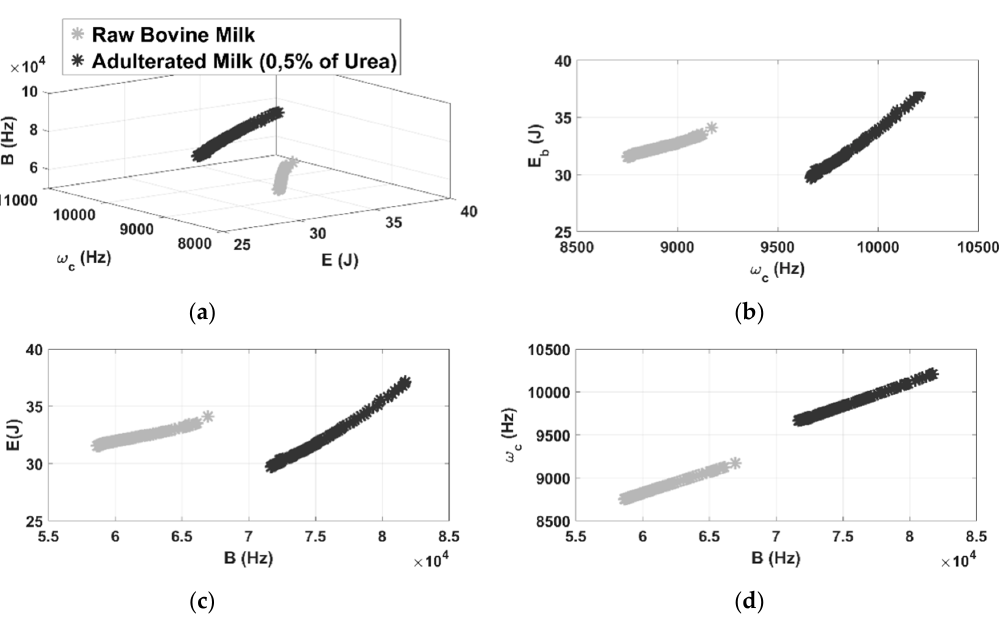
Figure 8. 3D representation of color maps for urea contamination ( a ) and 2D representation of color maps ( b – d ).